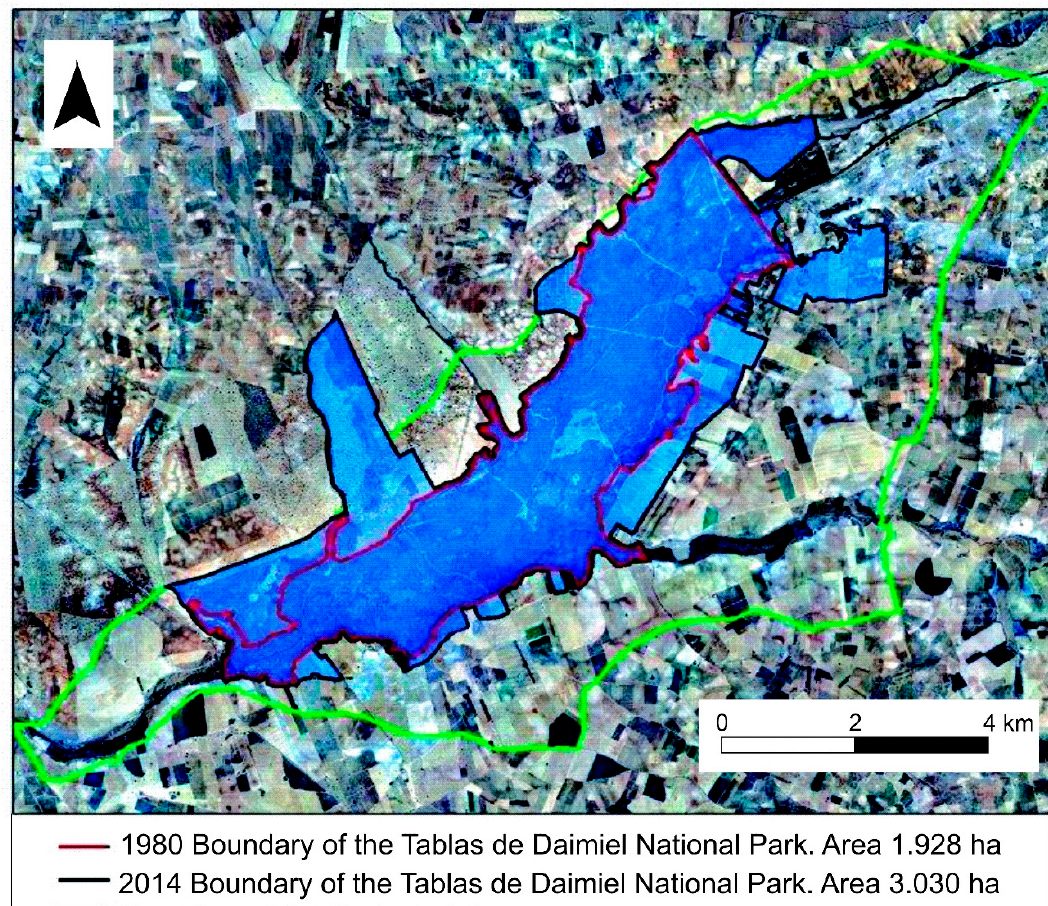
Figure 6. Limits and extent of Las Tablas de Daimiel National Park.